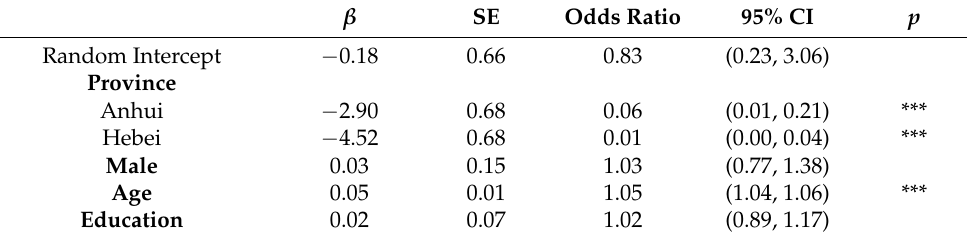
Table 2. Two-level logistic regression model of the effect of province on unrecorded bai jiu drinking. β SE Odds Ratio 95% CI p Random Intercept −